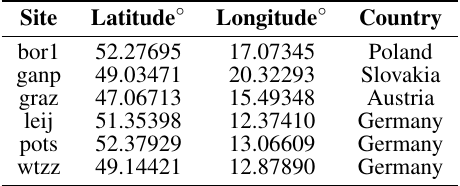
Table 1. The stations’ information (names, location (longitude and latitude) and country) for six selected sites of the IGS